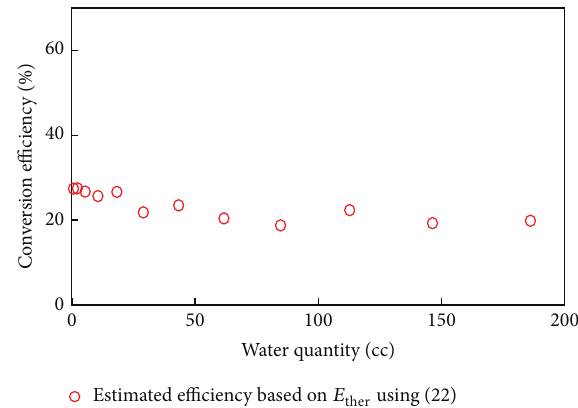
Figure 14: Estimated conversion efficiency at varying water quanti-